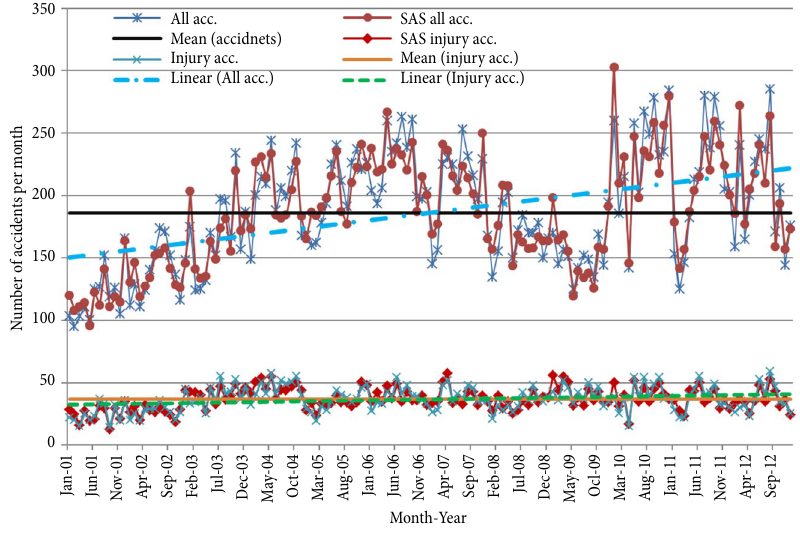
Fig. 2. Time series of all accidents and injury accidents on Slovenian